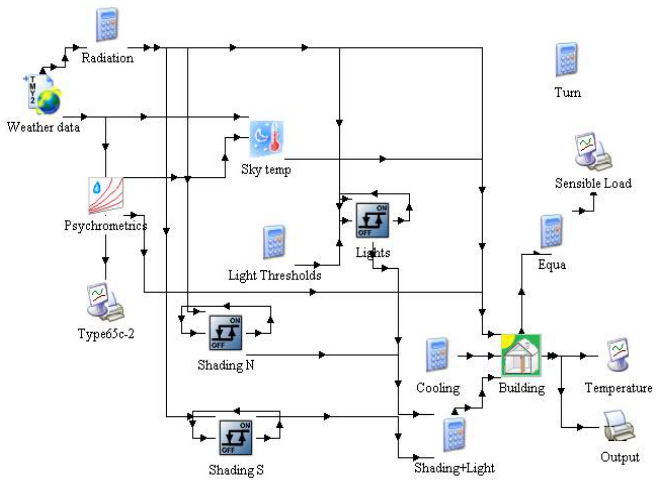
Figure 1. Calculation of annual dynamic cooling and heating hourly loadings.